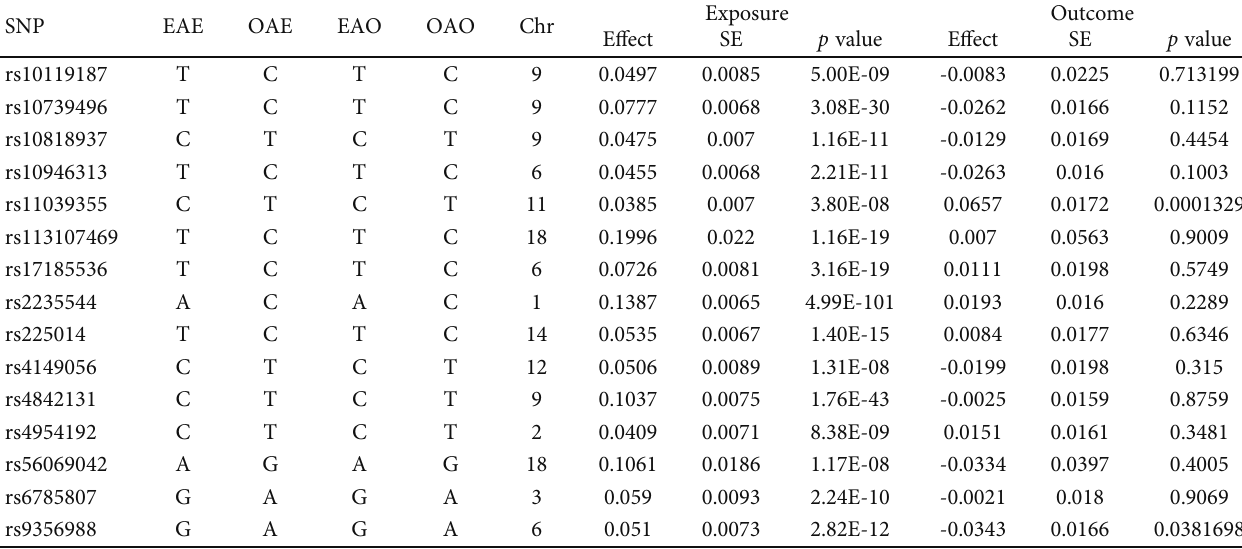
Table 2: Univariate Mendelian randomization analysis for the e ff ects of FT4 on venous thromboembolism